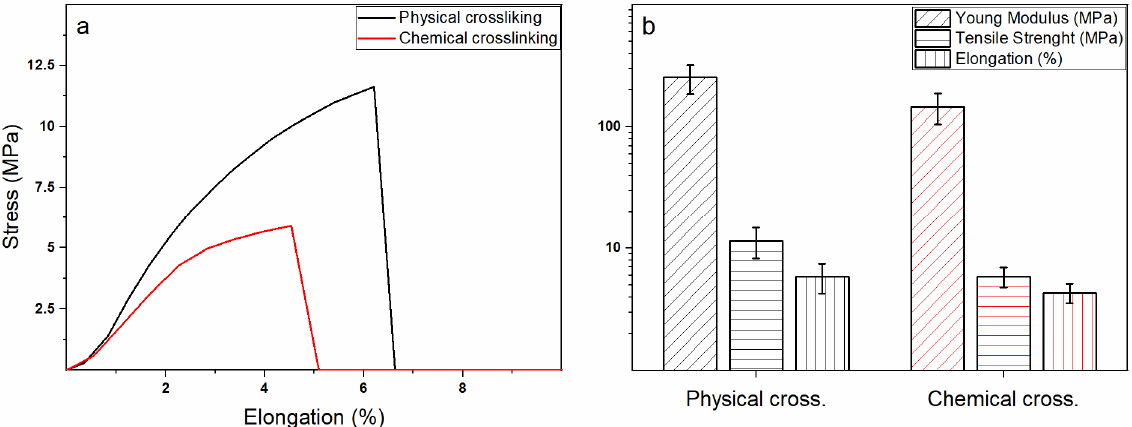
Figure 4. ( a ) Stress-deformation curves obtained from uniaxial tensile test for physically (black squares) and chemically crosslinked (red circles) electrospun mats. ( b ) Summary of the calculated mechanical properties (i.e., Young modulus E, elongation at break ε b , and tensile strength σ b ).